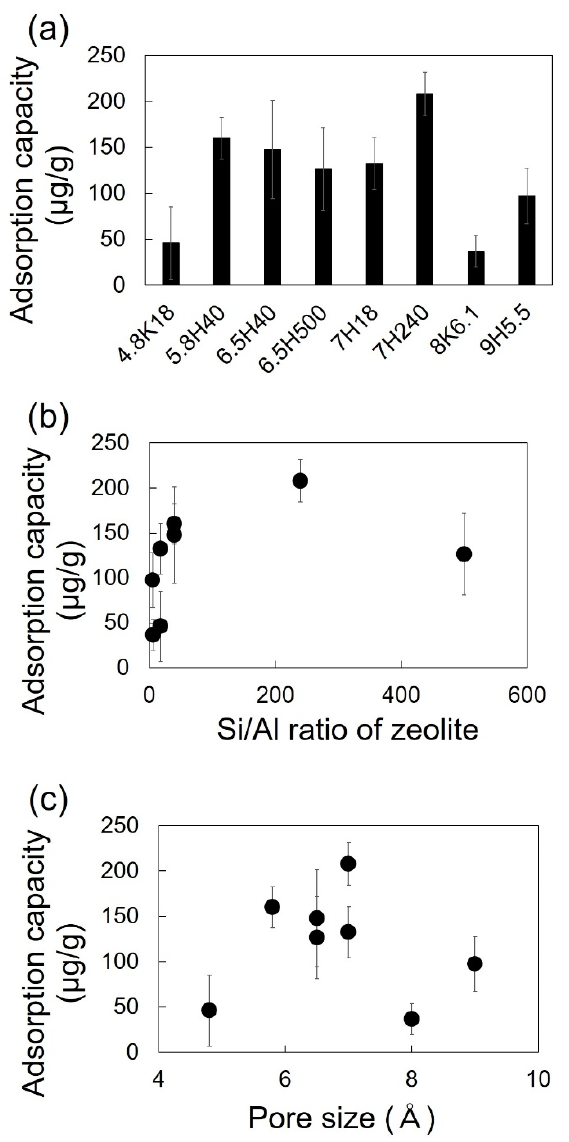
Figure 1. ( a ) The IS adsorption capacities of various zeolites after the 24 h adsorption test. ( b ) The IS adsorption capacities with the Si/Al ratios of each zeolite. The high Si/Al ratio indicates the large hydrophobicity of zeolite. ( c ) The IS adsorption capacities with the pore sizes of each zeolite. ( n =